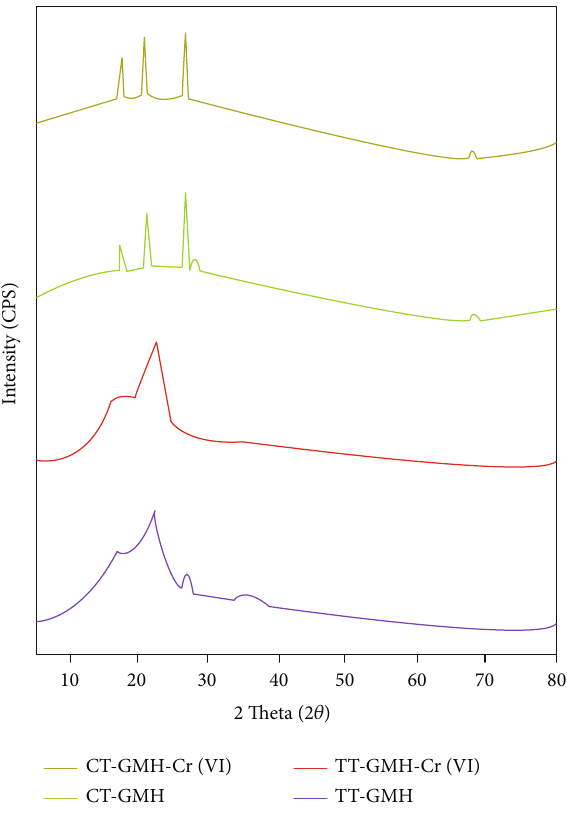
Figure 4: XRD spectrum of adsorbents TT-GMH and CT-GMH before and after adsorption of Cr(VI).